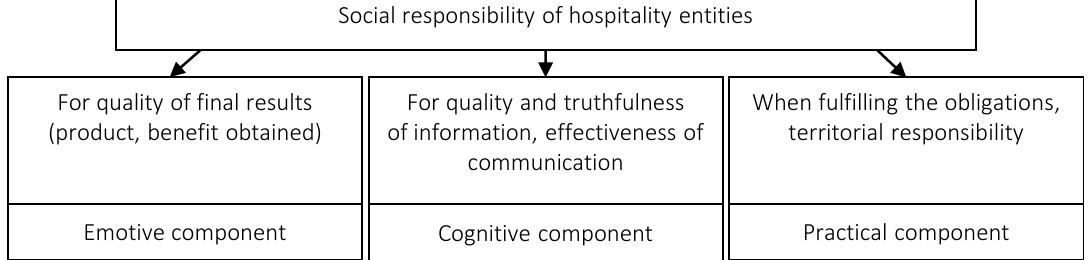
Figure 3. Essence of hospitality entities’ social responsibility for investments